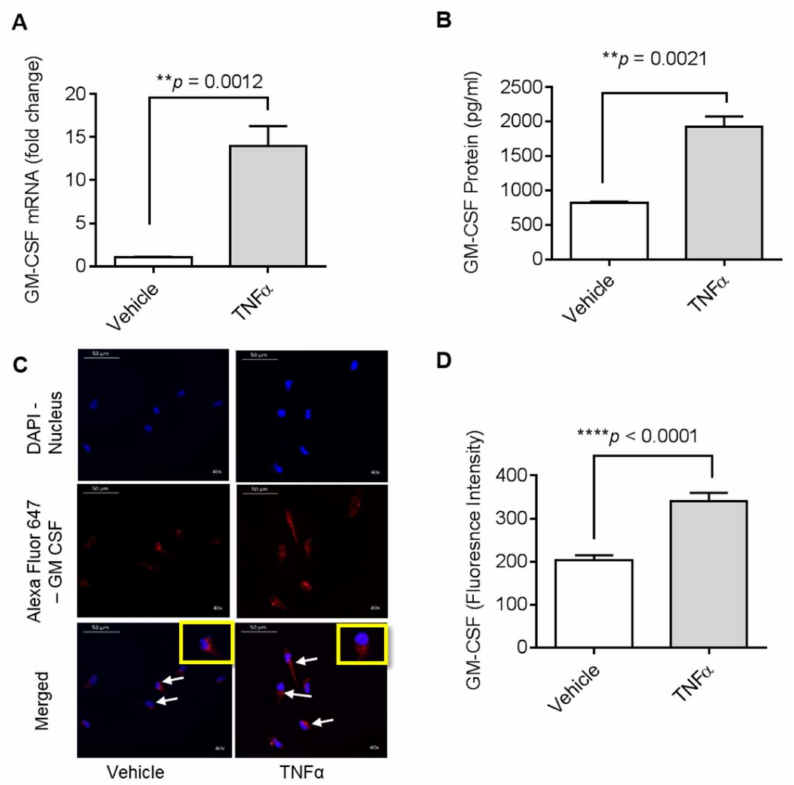
Figure 1. E ff ect of tumor necrosis factor- α (TNF α ) on granulocyte-macrophage colony-stimulating factor (GM-CSF) production in human MDA-MB-231 cells. MDA-MB-231 cells were cultured in 6-well plates at a concentration of 1 × 10 6 cells / well. Cells were treated with vehicle and TNF α (2 ng / mL), separately. After 24 h incubation, cells and supernatants were collected. ( A ) Total cellular RNA was isolated and GM-CSF mRNA expression was determined by real-time PCR. ( B ) Secreted GM-CSF in culture media was determined by ELISA. ( C ) MDA-MB-231 cells were treated with vehicle or TNF α for 24 h and then were stained with GM-CSF (red) and DAPI (blue). White arrows indicate typical stained cells. ( D ) GM-CSF fluorescence intensity is shown. The results obtained from three independent experiments are shown. All data are expressed as mean ± SEM ( n ≥ 3). ** p < 0.01, **** p < 0.0001 versus